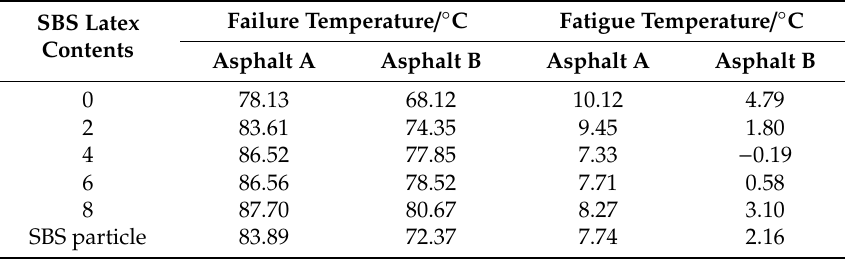
Table 2. Failure temperature and fatigue temperature of all asphalt